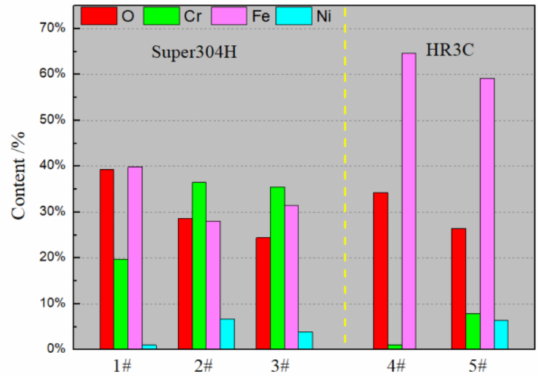
Figure 5. Elementary composition of five identifying spots corresponding to Figure